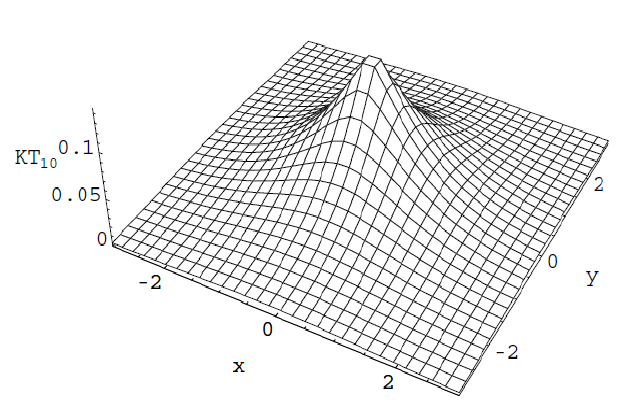
Figure 4. The bivariate 10-order generalized